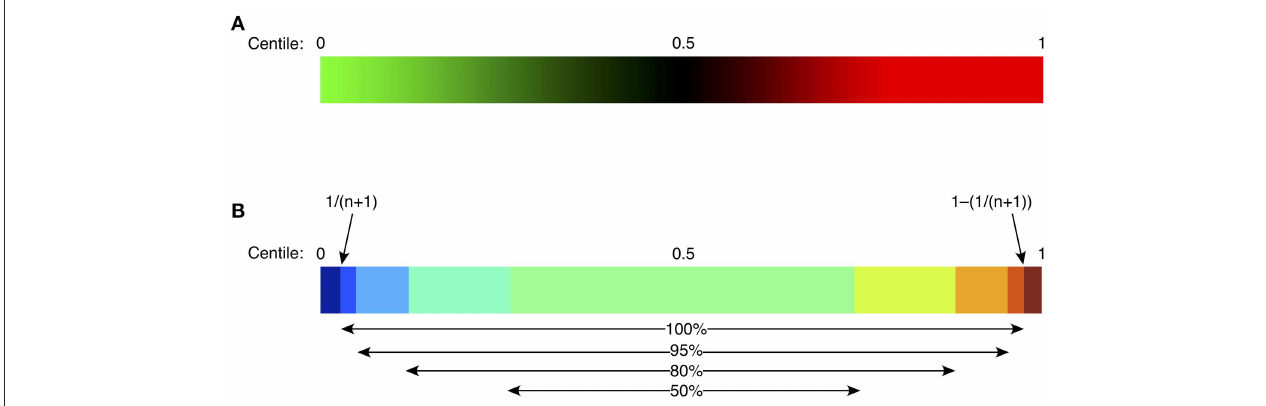
FIGURE 2 | Heat mapping strategy for continuous green-black-red shading (A) , or discontinuous shading (B) . For continuous shading, colors vary continuously in shades of green (below control median), or red (above control median) with an intensity proportional to the difference from the median (0.5 centile). For discontinuous shading, colors vary stepwise as shown, based on the difference from the median, with the middle 50% of the control population in pale green, then progressively from light to dark blue (below control median), or yellow/orange/red/brown (above control median). Centiles for the control population are defined to vary from 1/(n + 1) to 1–[1/(n + 1)], depicted as “100%” in (B) , where n is the size of the control population; such an approach allows identification of “extreme” or unprecedented values, namely those lying outside the bounds of the control population. Other percentages represent the proportion of the control population included in each indicated color